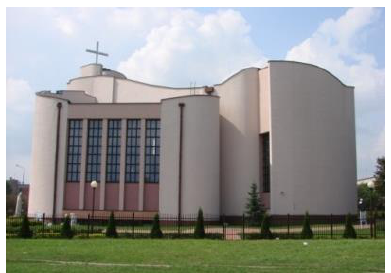
Figure 10. Church of Virgin Mary Mother of the Church in Radomsko (built in